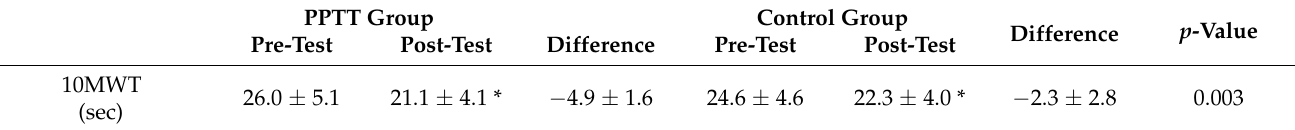
Table 4. Changes in the gait speed of the study participants (N =